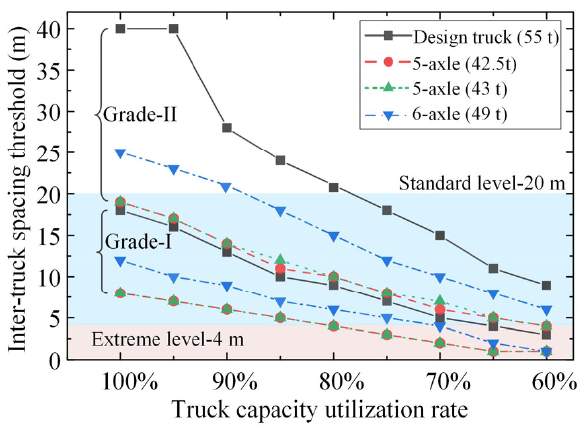
Figure 10. Inter-truck spacing thresholds for ATP crossing simply supported bridges with different truck capacity utilization rates (identified based on the shear force under two-truck ATP loads with a reduction of 2 m in the critical wheelbase).